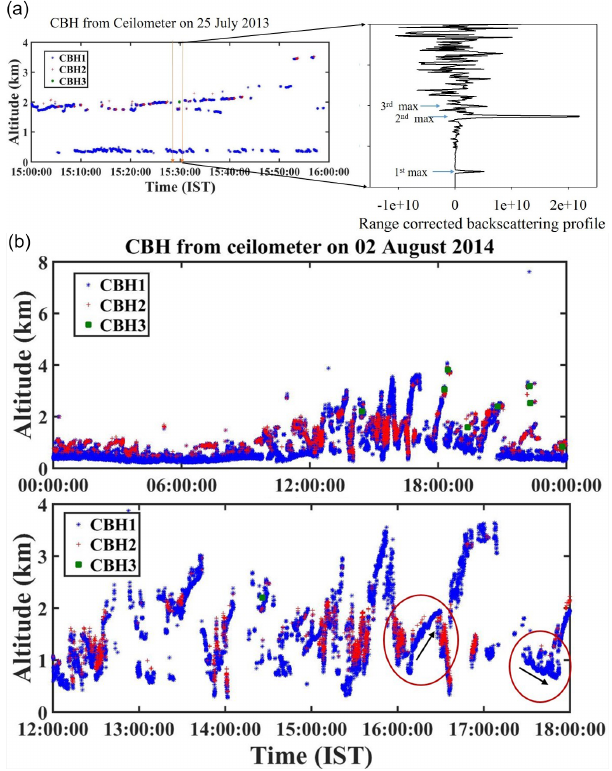
Figure 3. (a) Cloud intensity with range-corrected backscatter- ing profile for multilayer cloud detection on 25 July 2013 at 15:29:50IST. (b) Evolution of three layers of CBH measured by the ceilometer on 2 August 2014 (upper panel) along with strong updraft and downdraft (lower panel) for the same